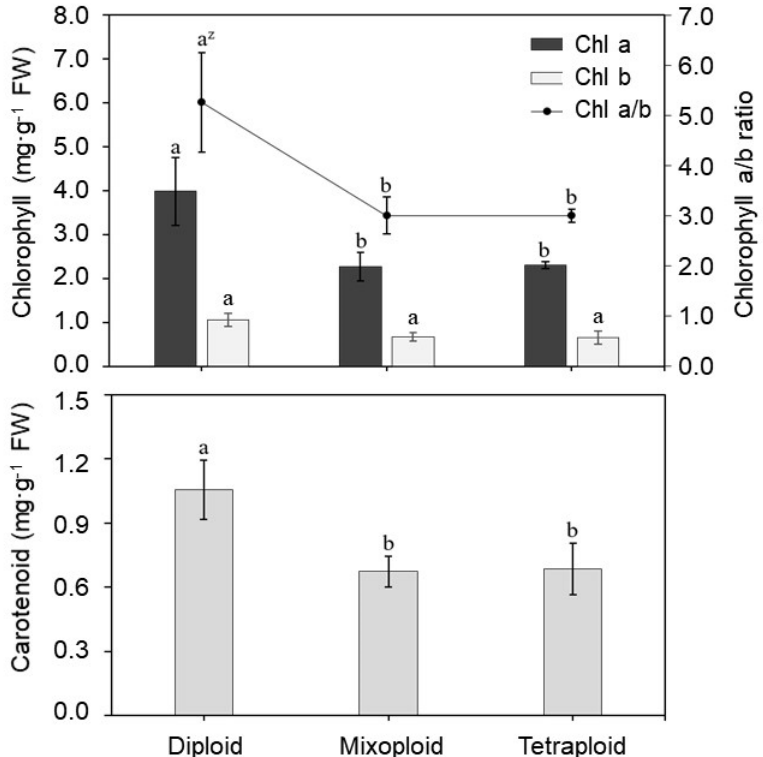
Figure 4. Chlorophyll and carotenoid contents of diploid, mixoploid, and tetraploid C. officinale plants. Data represent mean ± SE. Different letters indicate significant differences ( p < 0.05; Duncan’s multiple range test).